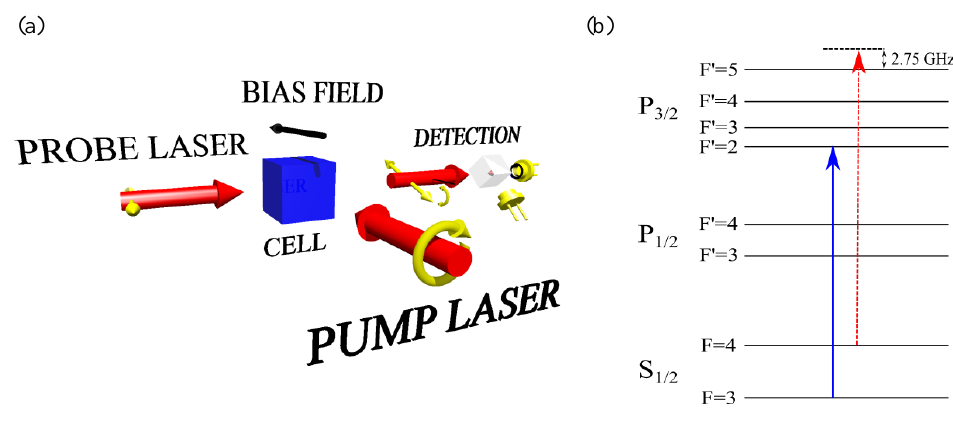
Figure 2. ( a ) Components of the radio-frequency atomic magnetometer setup. ( b ) Caesium 6 2 S 1/2 → 6 2 P 1/2 transition (D1 line) and 6 2 S 1/2 → 6 2 P 3/2 transition (D2 line) energy structure. The arrows represent the frequency of the laser beams used in the experiments. Pump beam (solid blue line) along with spin-exchange collisions create a population imbalance among the Zeeman sublevels of the F = 4 ground state manifold. The signal is created by polarization rotation of the probe beam (dotted red